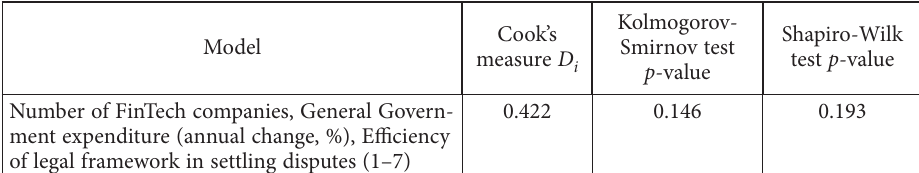
Table 6. Verification of the normal distribution of data resides in the multiple linear regression equa- tion (source: